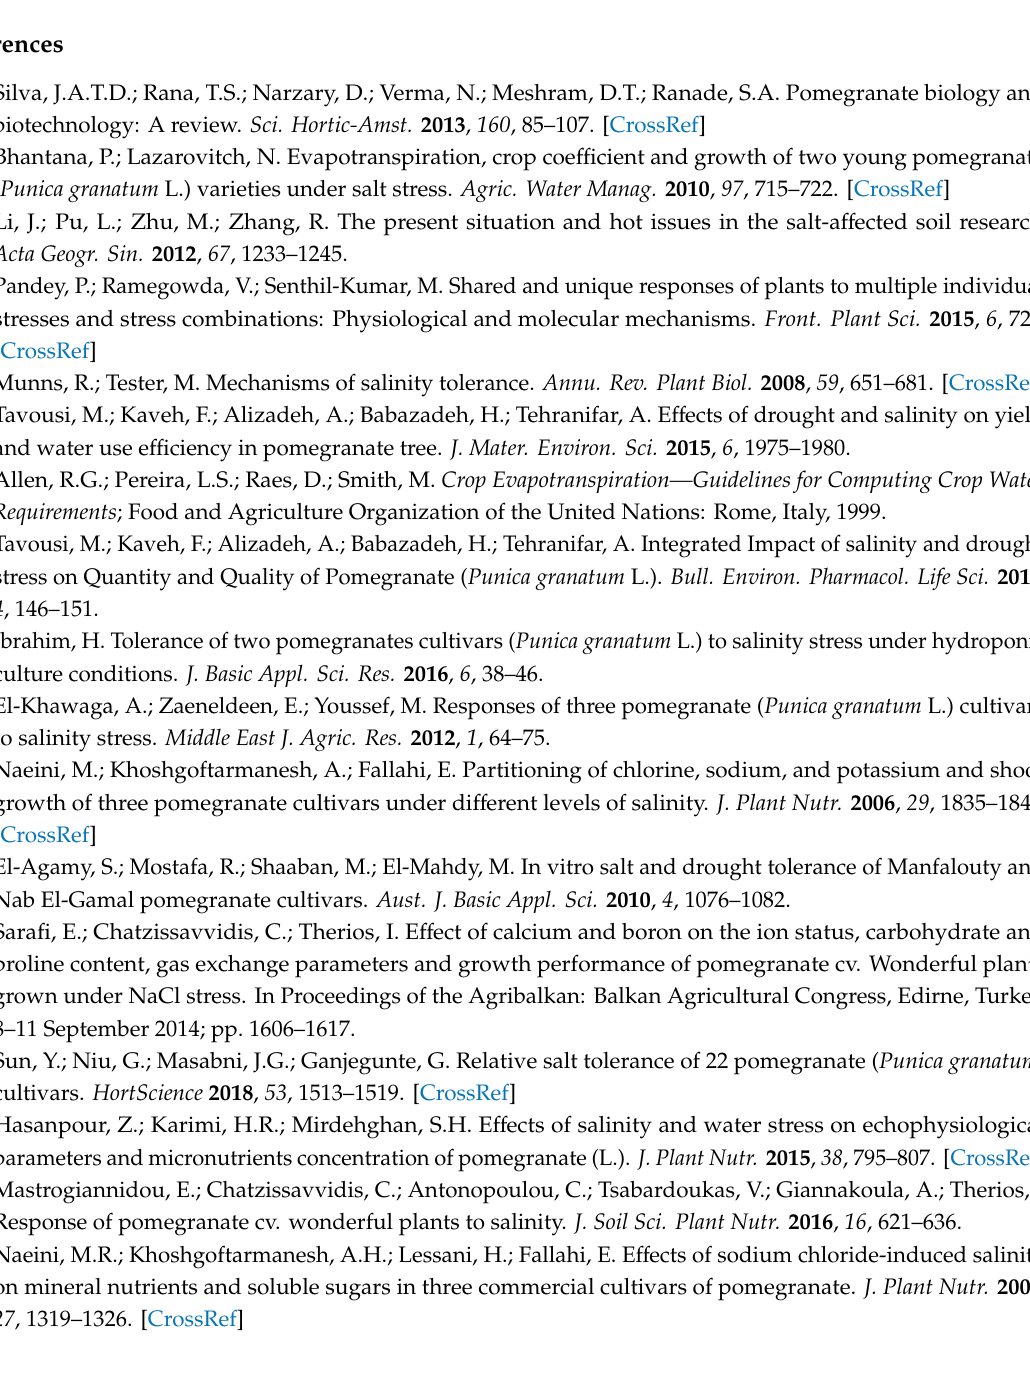
Table S1: The accumulation of macroelements in pomegranate roots, stems and leaves under salt stress, Table S2: The accumulation of microelements in pomegranate roots, stems and leaves under salt stress, Table S3: The ratio of K / Na and Ca / Na in pomegranate